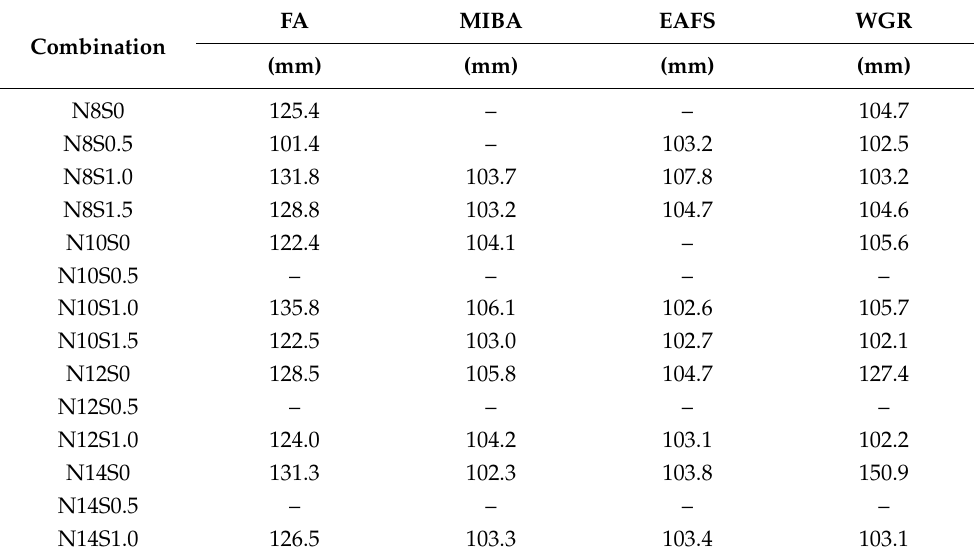
Table 5. Flow table results of FA, MIBA, EAFS, and